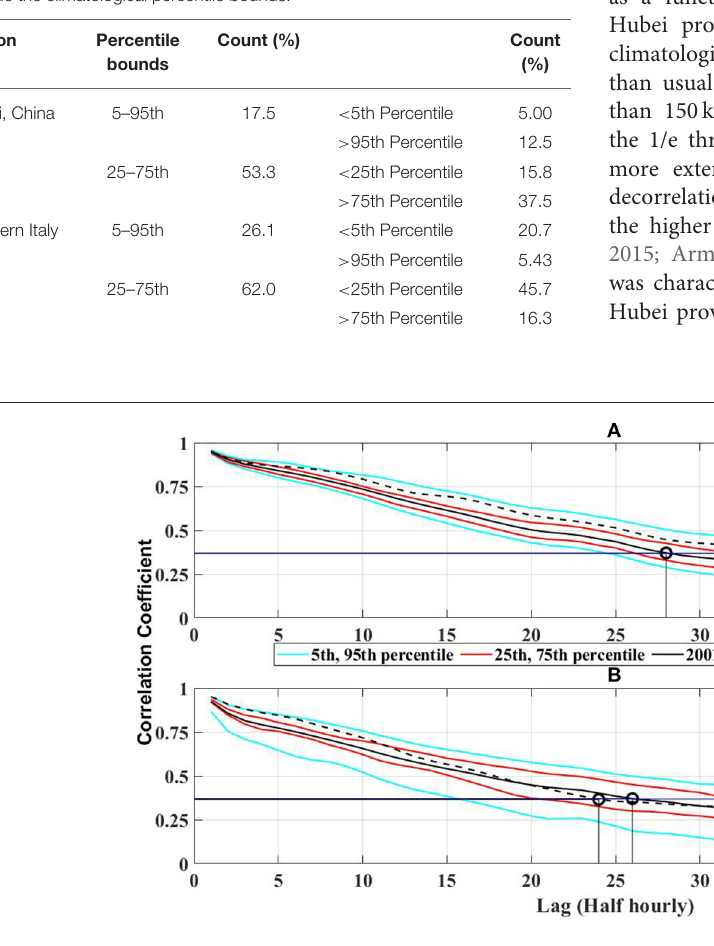
FIGURE 6 | Variogram of temporal correlations for a half hourly precipitation in the (A) Hubei province during January-April, 2001–2020 and (B) Northern Italy during March-May, 2001–2020, showing the mean, 5th, 25th, 75th, and 95th percentiles for 2001–2019 and the mean for 2020. The horizontal solid line represents a correlation value of 1/e and the corresponding decorrelation